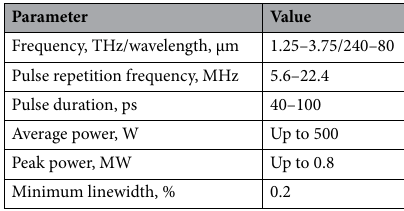
Table 3. Parameters of irradiation by